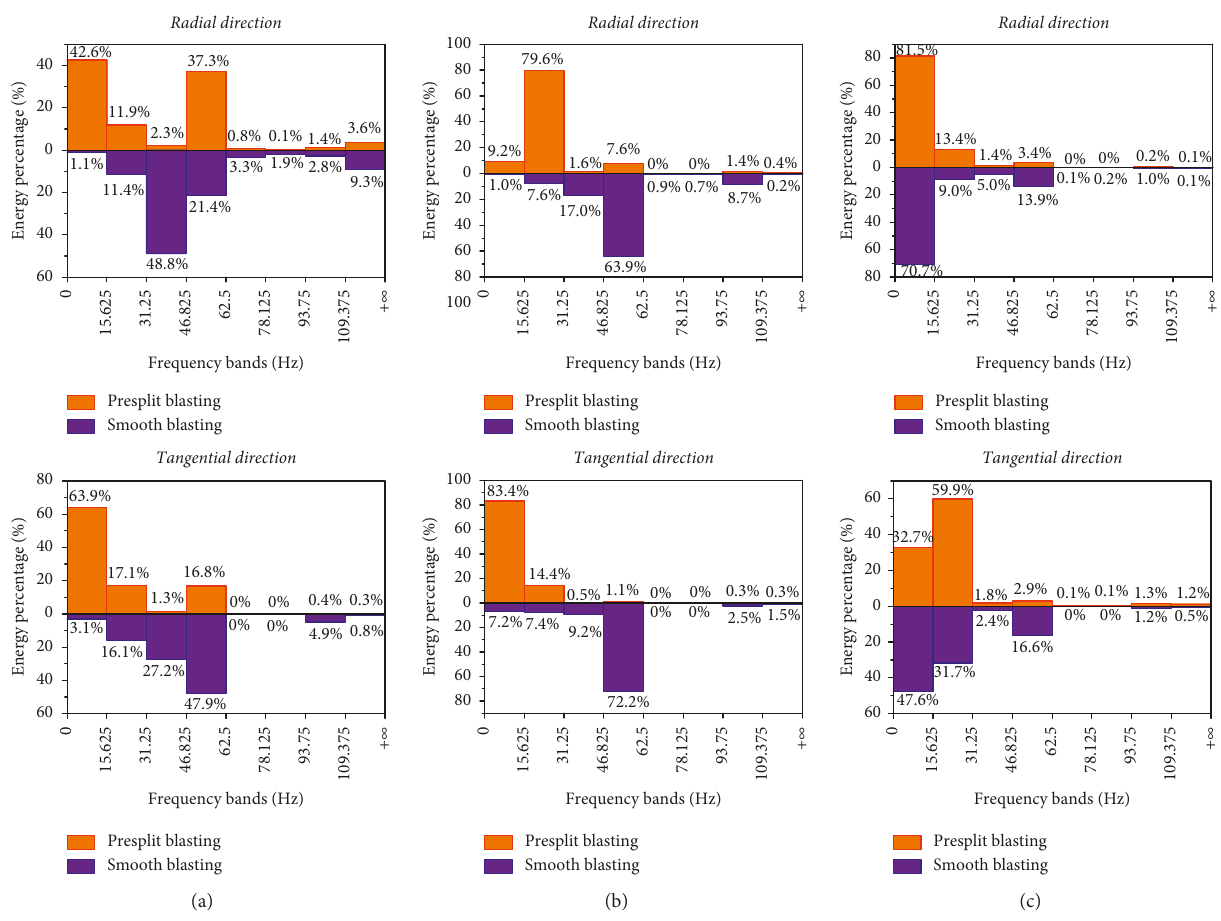
Figure 11: The percentages of energy distribution from peripheral boreholes in different frequency bands based on smooth and presplit blasting at different monitoring distances. (a) 30m. (b) 50m. (c)